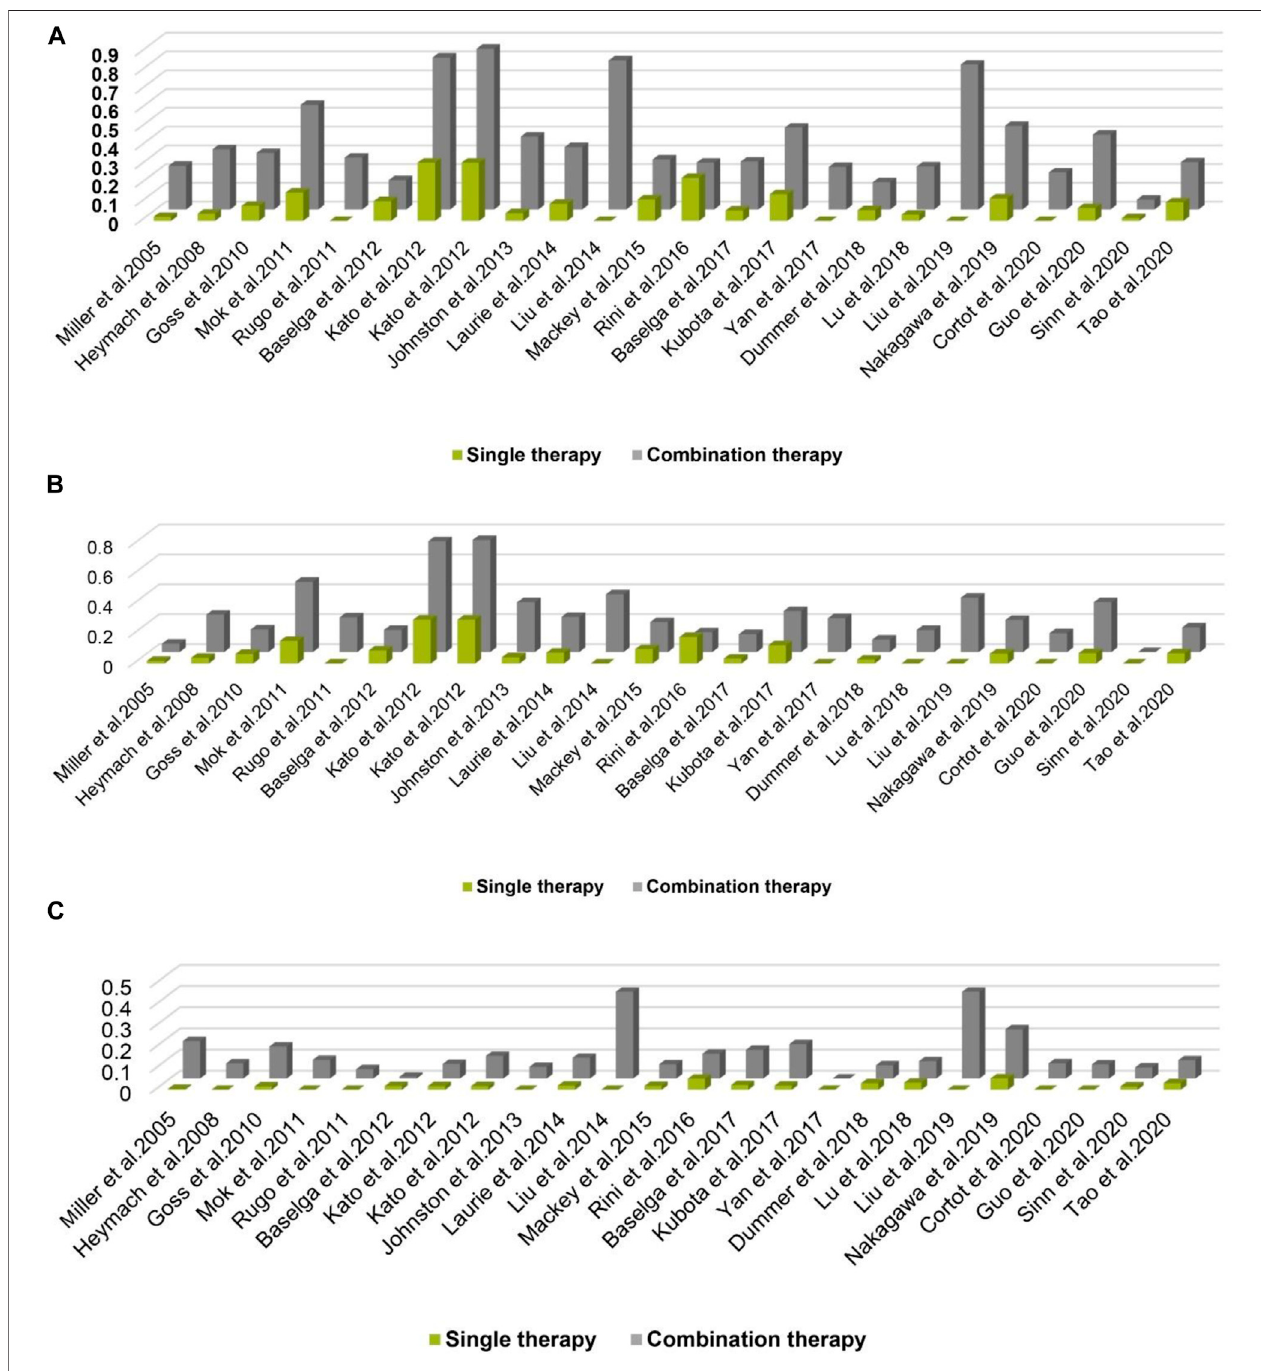
FIGURE 5 | Incidence rate of